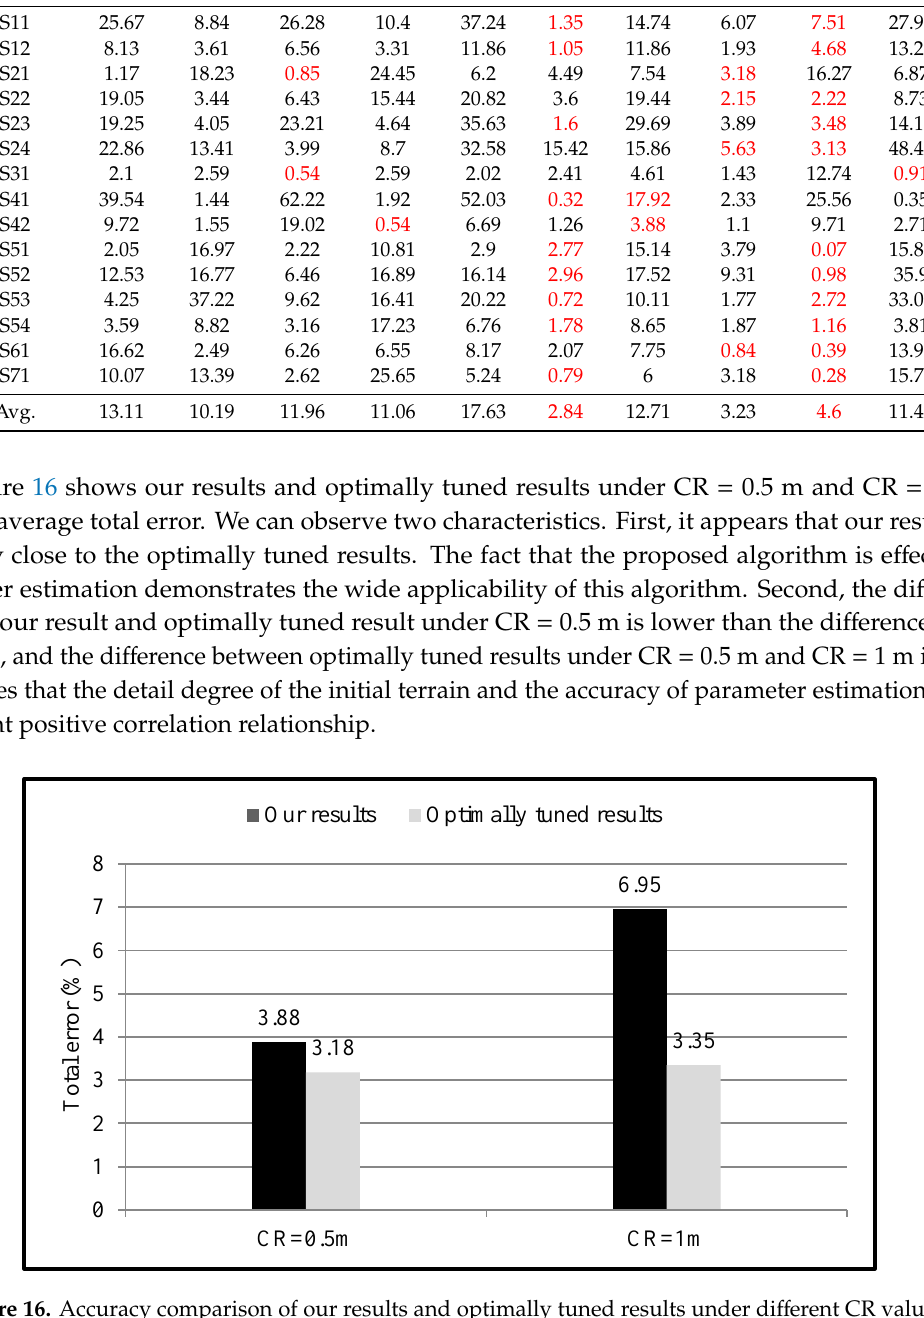
Figure 16. Accuracy comparison of our results and optimally tuned results under different CR values.